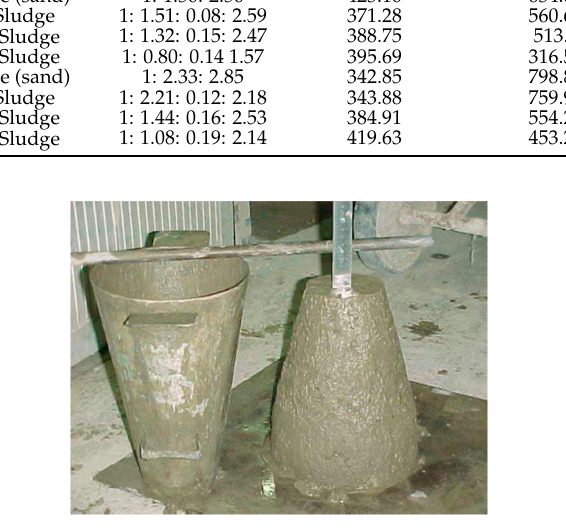
Figure 1. Slump cone test method.